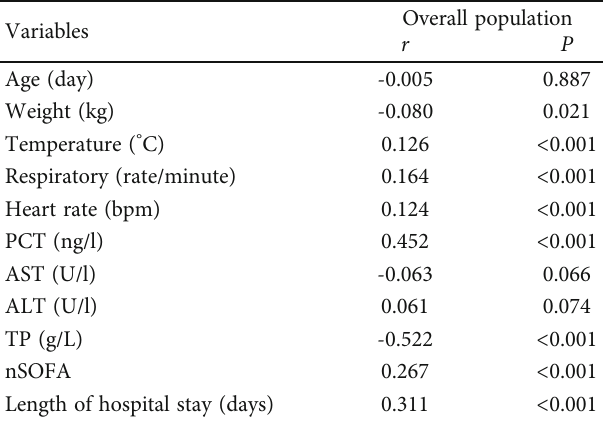
Table 3: Correlations between CAR and clinical